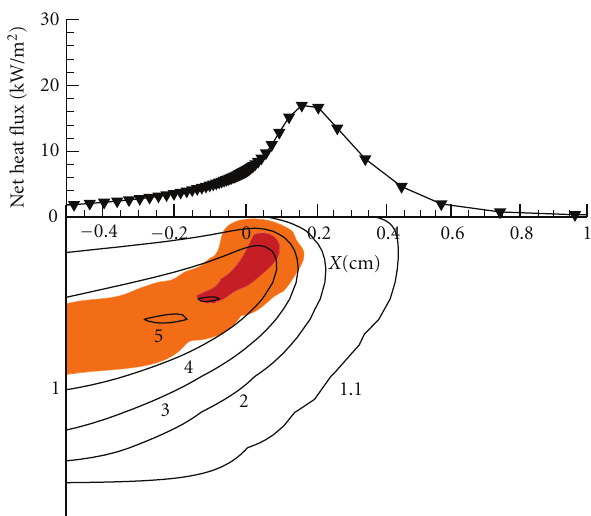
Figure 2: Computed flame (shaded region); temperature field (bottom) (1 unit = 300 K); and net heat flux on the fuel